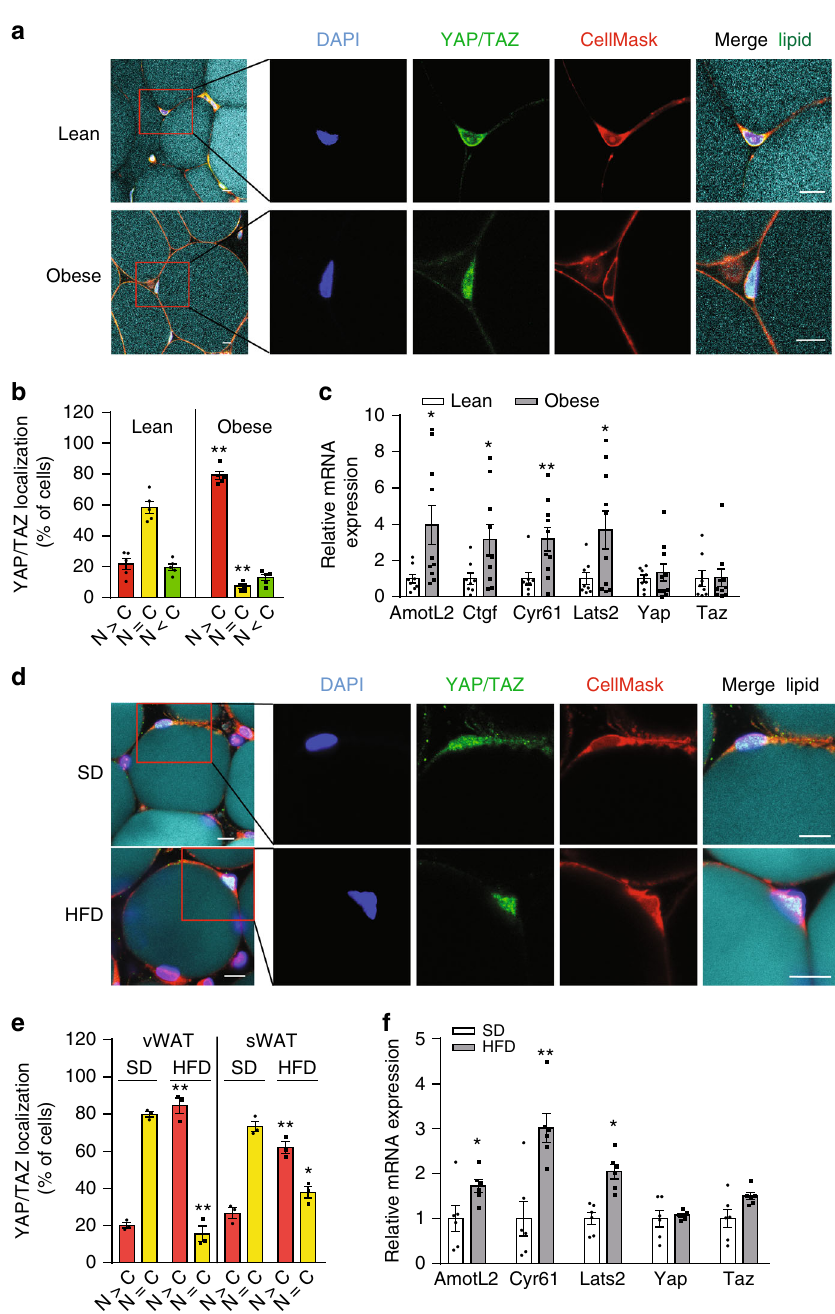
Fig. 1 Obesity promotes YAP/TAZ activation in white adipocytes. a , d vWAT from lean (body mass index < 25) and obese subjects (body mass index > 30) ( a ) or from mice fed HFD for 4 weeks and mice fed standard diet (SD) ( d ) was stained with anti-YAP/TAZ antibody, DAPI, CellMask to visualize adipocyte plasma membranes and LipidTOX (lipid). Scale bars: 10 µ m. b , e Quanti fi cation of YAP/TAZ localization to the nucleus (N) or cytosol (C) in visceral white adipocyte of human lean ( n = 5), and obese subjects ( n = 5) ( b ) or in the visceral (vWAT) and subcutaneous white adipose tissue (sWAT) from standard diet (SD)-fed ( n = 3) and HFD-fed mice ( n = 3) ( e ). c , f Expression of YAP/TAZ target genes, and of Yap and Taz in white adipocyte isolated from human visceral adipocytes of lean ( n = 8) and obese subjects ( n = 10) ( c ) or from the vWAT of mice fed HFD ( n = 6) or standard diet (SD) ( n = 6) for 4 weeks ( f ). Data are presented as the mean ± SEM; * p ≤ 0.05 and ** p ≤ 0.01 (compared to lean humans or standard diet (SD)-fed mice in b , e ) (unpaired Student ’ s t -test). Source data are provided as a Source Data fi